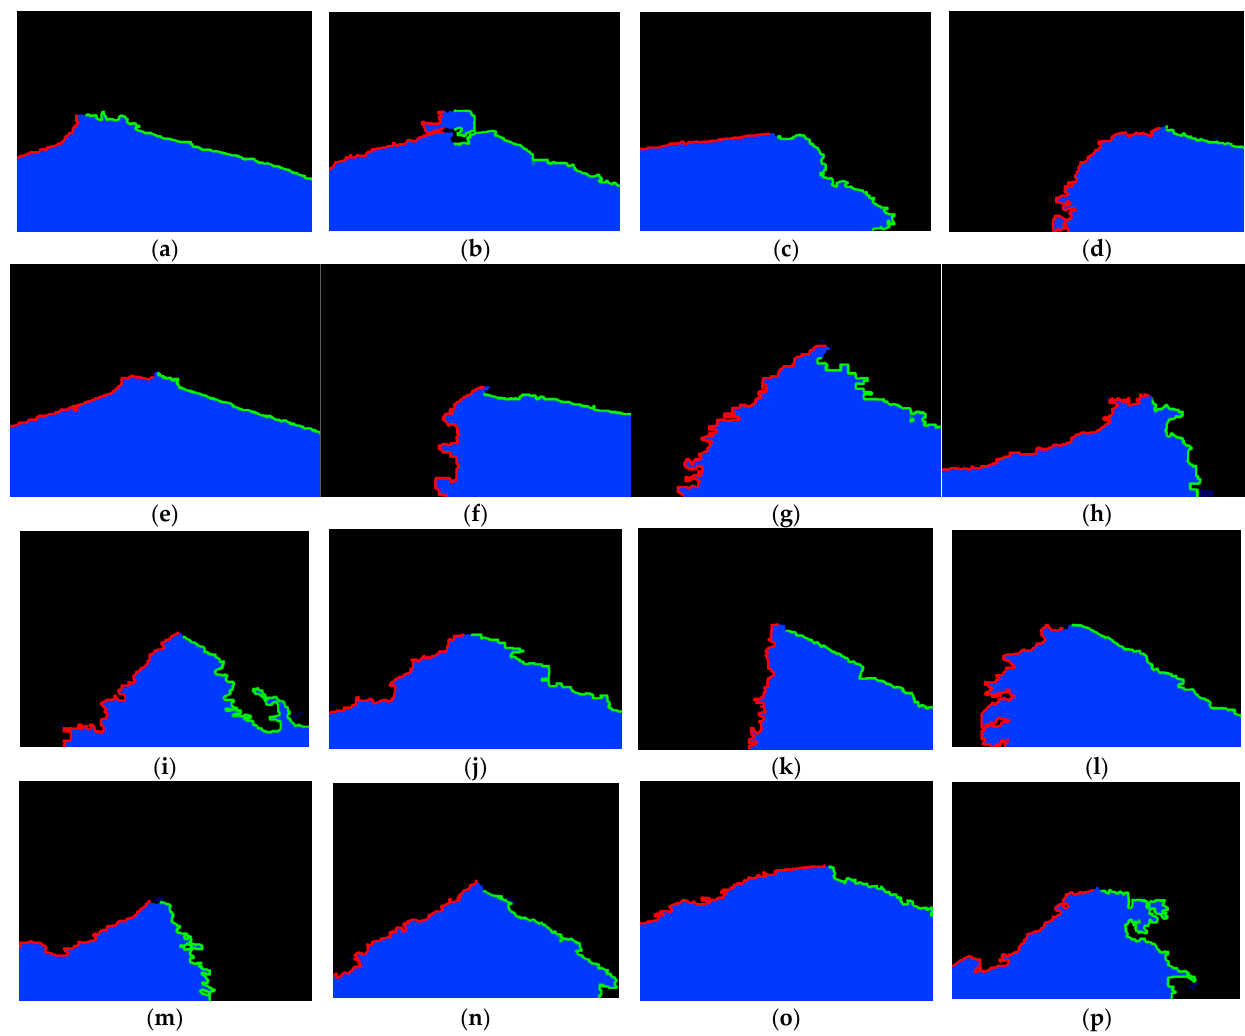
Figure 7. SVM-based binary images of road areas and non-road areas, and extraction of irregular road boundaries. ( a – f ) are from RUGD; ( g – k ) are from Jiufeng Forest Farm; ( l – p ) are from Liaocheng Forest Farm.